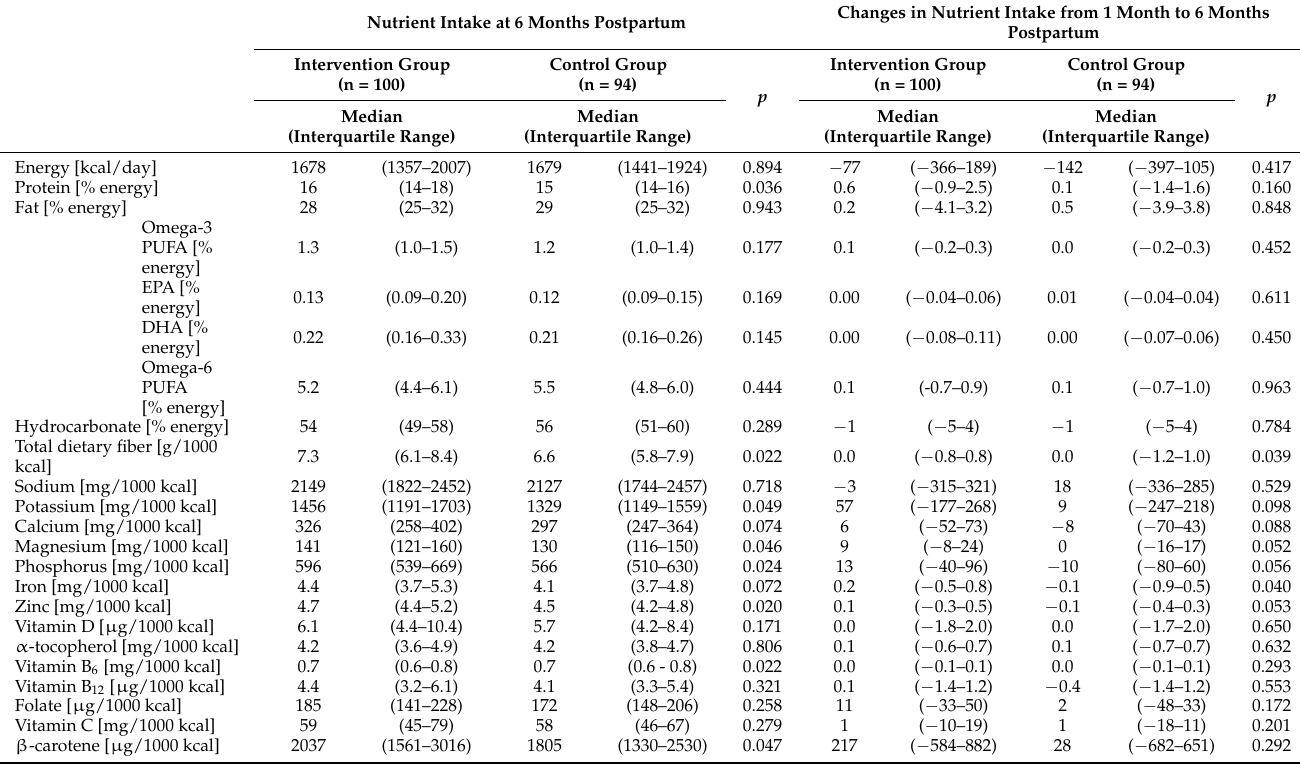
Table 4. Changes in nutrient intake from 1 month to 6 months